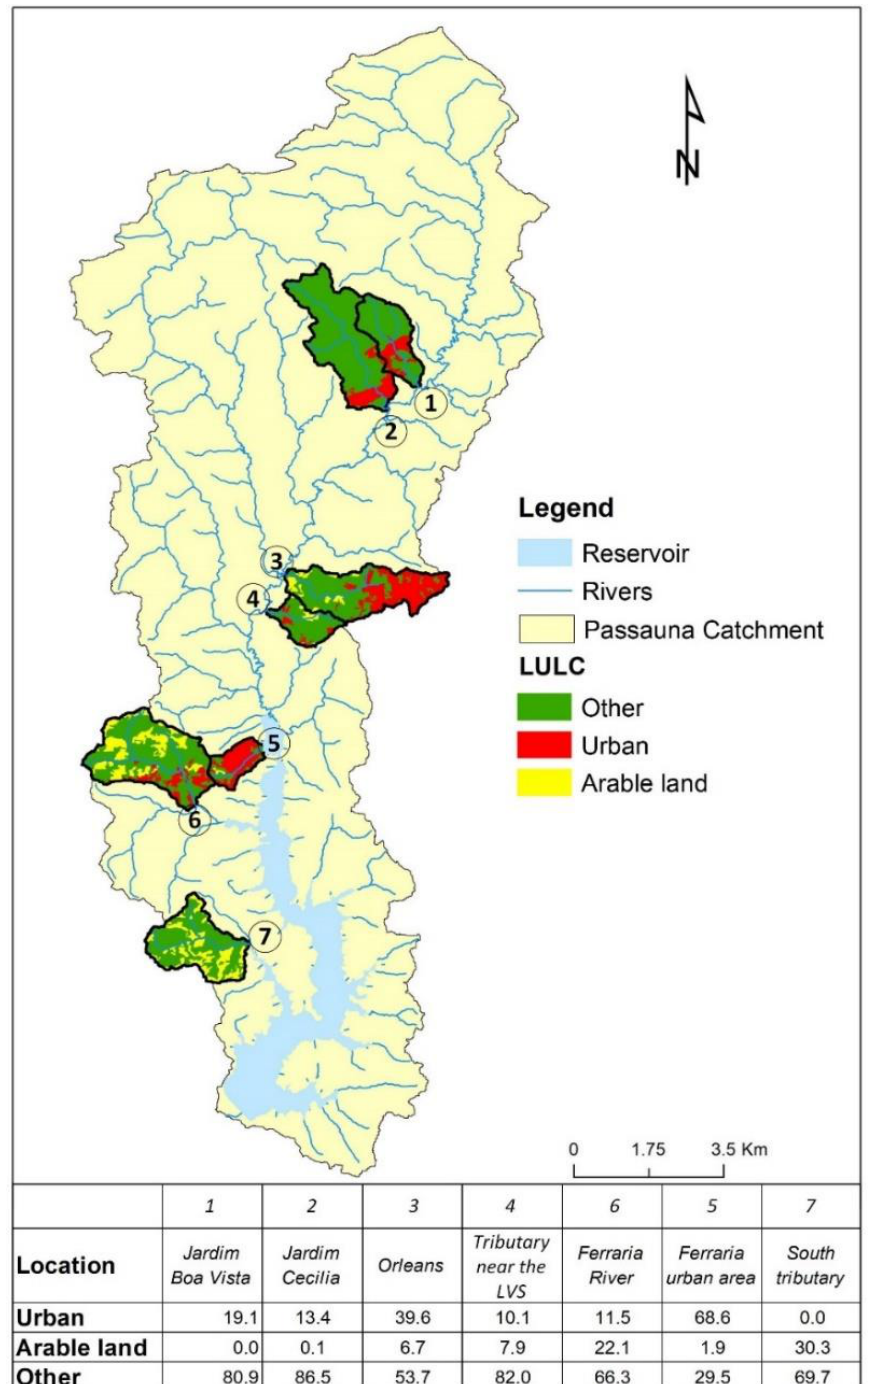
Figure 3. River sampling locations and their respective catchment. The table shows the share of each land cover class in percentage.